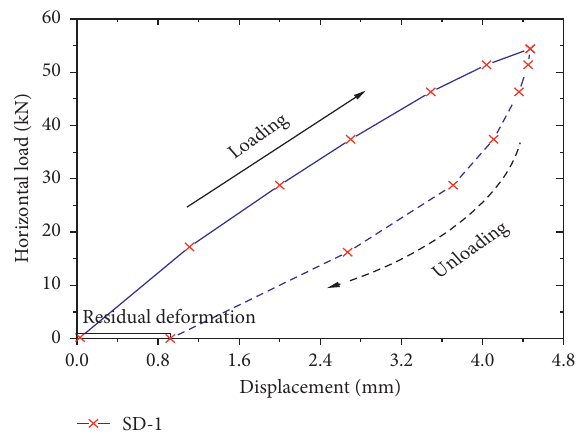
Figure 15: The load-displacement curve of elastic